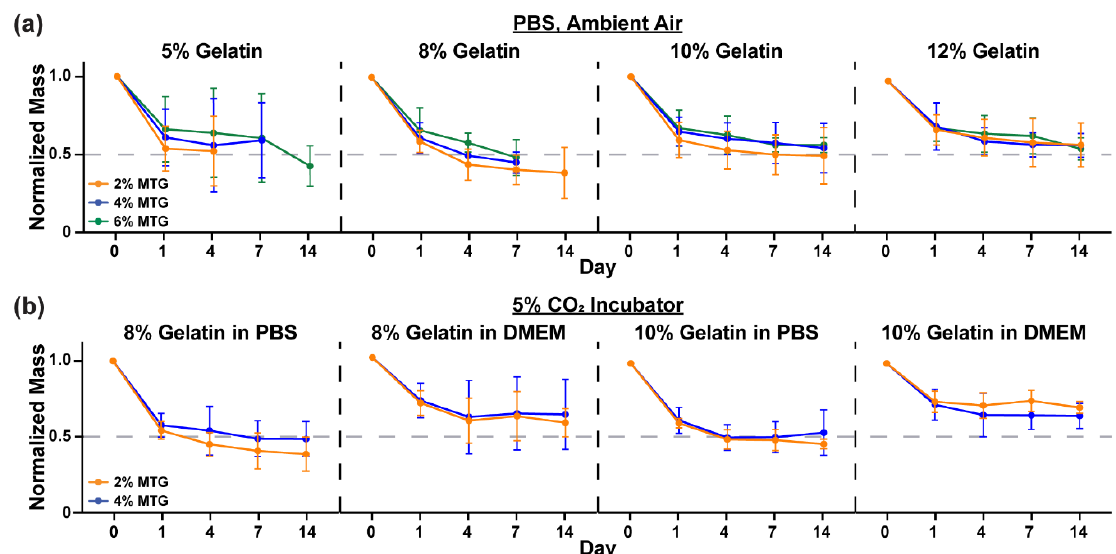
Figure 4. Normalized mass of gelatin-MTG hydrogels over 14 days in ( a ) PBS and ambient air and ( b ) PBS or DMEM and 5% CO 2 . Bars indicate standard deviation, n = 3–4. For some conditions, datapoints are excluded because the samples degraded prior to the measurement.